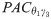
Mechanisms mediating indirect PAC connections (Case I).A) Three population toy model comprising three neuronal populations labelled as ‘1’, ‘2’, and ‘3’, oscillating in the theta (θ), delta (δ), and gamma (γ) bands. B) PAC involving the phase of theta in population 1 and the amplitude of gamma in population 3 (PACθ1γ3) obtained when varying the connectivity parameters between populations 1 and 2 (Γ12 = 30:4:1000) and between populations 2 and 3 (Γ23 = 30:4:1000). Panels C to R, displays the 16 predictors used in the ten models explored (Table 2). S) Coefficient of determination (R2) for the ten models explored (Table 2). T) Correlation coefficient between the 16 predictors.